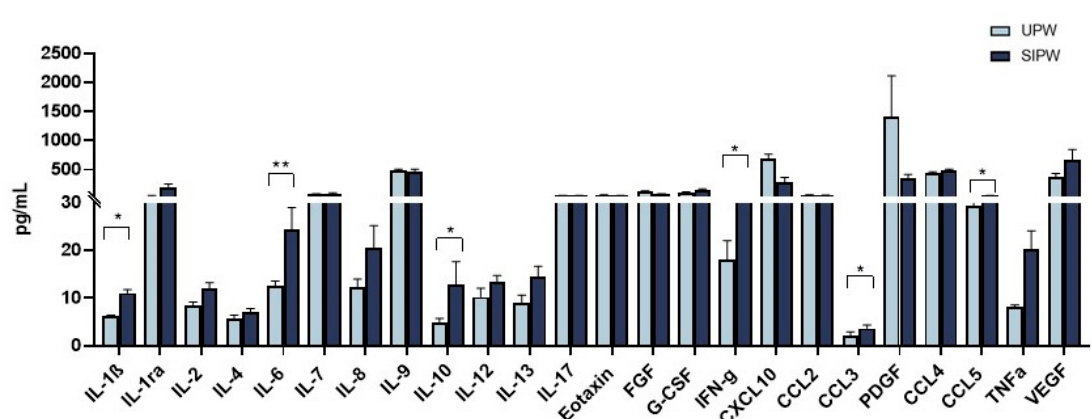
Figure 4. Plasma secretion of cytokines/chemokines that are part of the inflammatory response. The production of 27 cytokines/chemokines regulating immune response was assessed by Luminex assay in plasma of 6 UPW (light blue bars) and 15 SIPW (blue bars). Values are mean ± SEM. Significance is indicated, as follows: * = p < 0.05 and ** = p < 0.01.